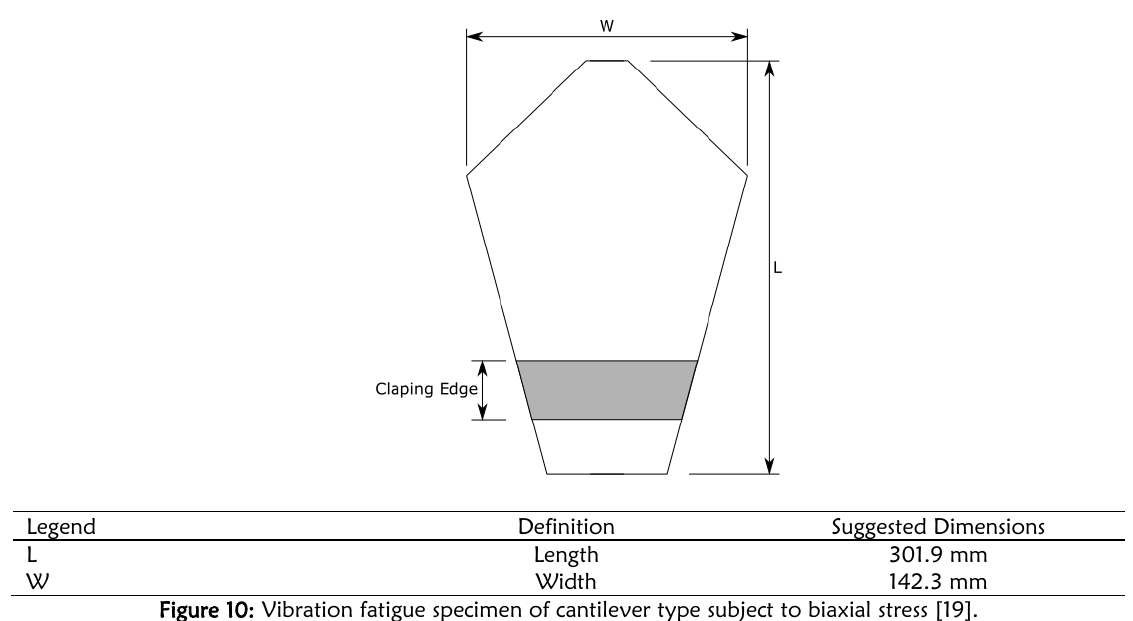
Figure 10: Vibration fatigue specimen of cantilever type subject to biaxial stress [19].